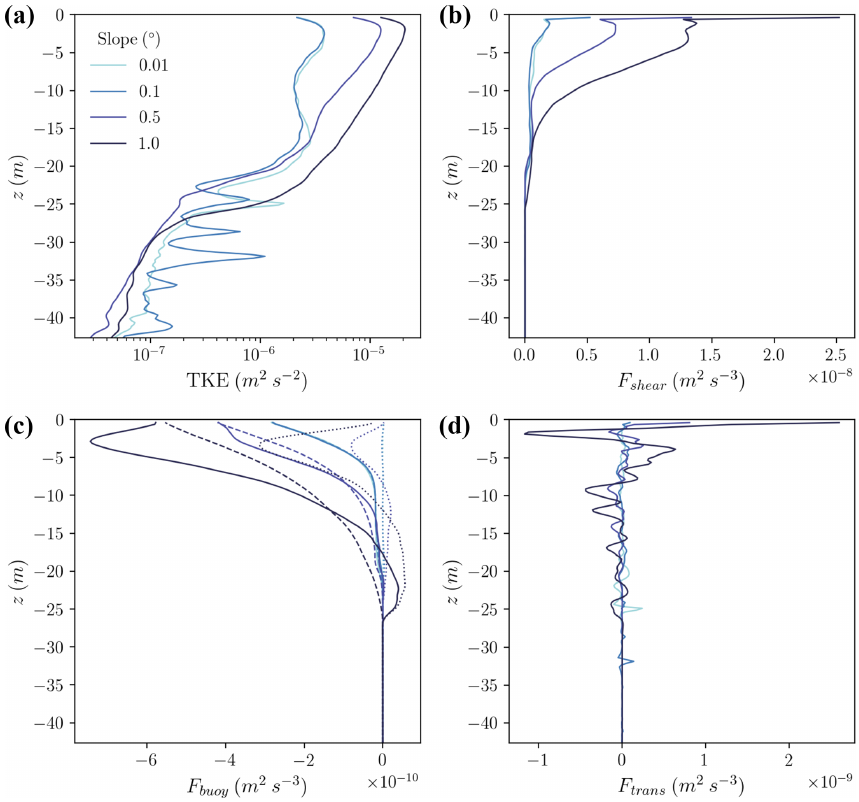
Figure 5. (a) Simulated turbulence kinetic energy (TKE) and (b–d) TKE source terms for variable slope simulations averaged over the last inertial period. (b) Shear production. (c) Buoyancy production: total (solid lines), vertical component (dashed), and upslope component (dotted). (d) TKE transport. Positive denotes production and negative destruction of TKE. Note that the x -axis scales differ between